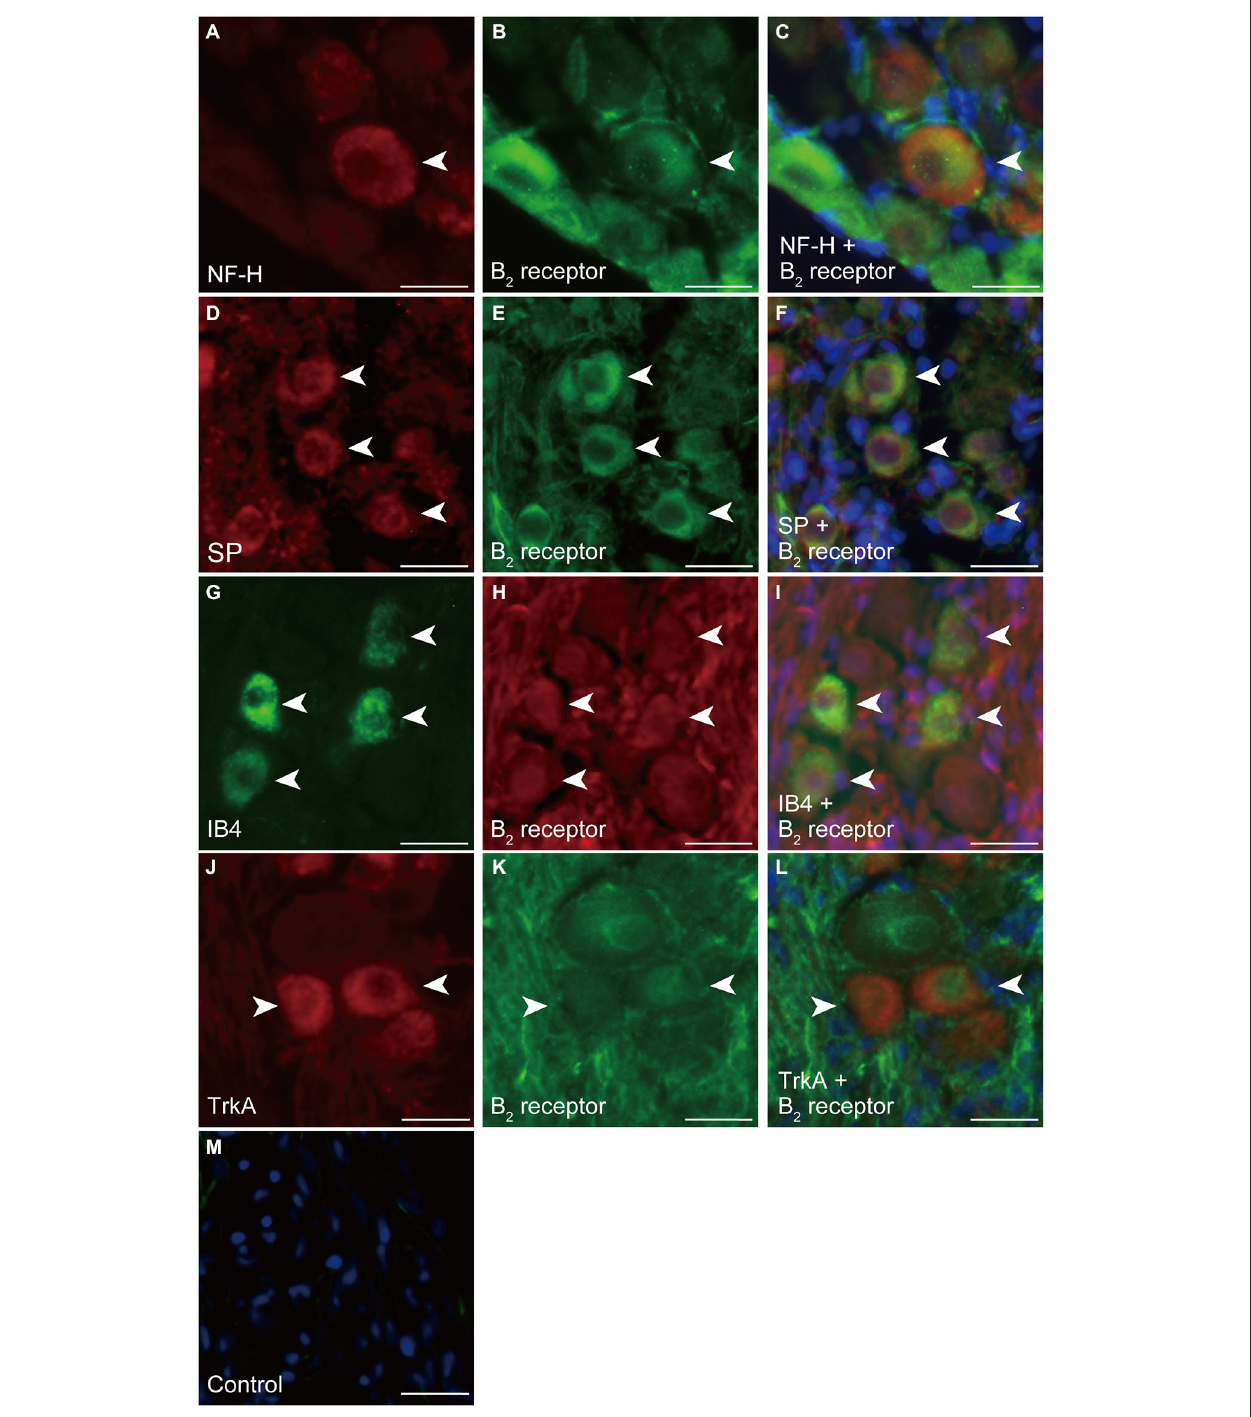
receptors (green) and SP (red). Nuclei are shown in blue. (G) Positive immunoreactivity to IB4 as a non-peptidergic C-neuron marker in TG neurons (arrowheads). (I) Triple staining with antibodies against B 2 receptors (red) and IB4 (green). Nuclei are shown in blue. (J) Positive immunoreactivity to TrkA as an nerve growth factor (NGF)-responsive nociceptor marker in TG neurons (arrowheads). (L) Triple staining with antibodies against B 2 receptors